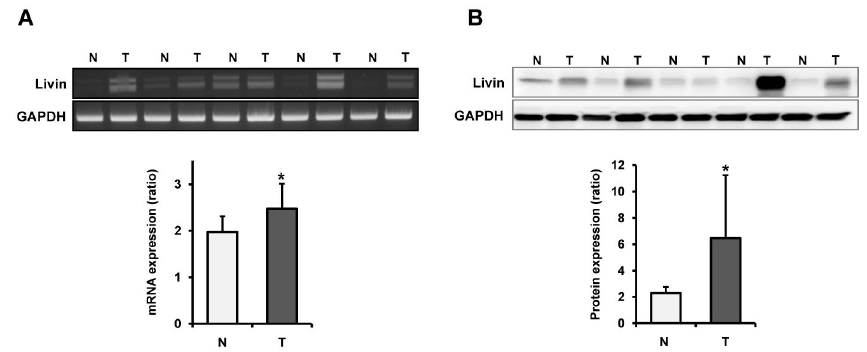
Figure 5. Expression of Livin mRNA and protein in fresh colonoscopic biopsy specimens. (A) Livin mRNA expression (B) Livin protein expression. Expression of Livin is upregulated in cancer tissues compared to paired normal mucosa at mRNA and protein levels in fresh colonoscopic biopsy specimens. Each bar represents the mean ± SE of 20 cases. *p<0.05 versus normal colorectal mucosa. T; colorectal cancer tissue, N; paired normal colorectal mucosa.